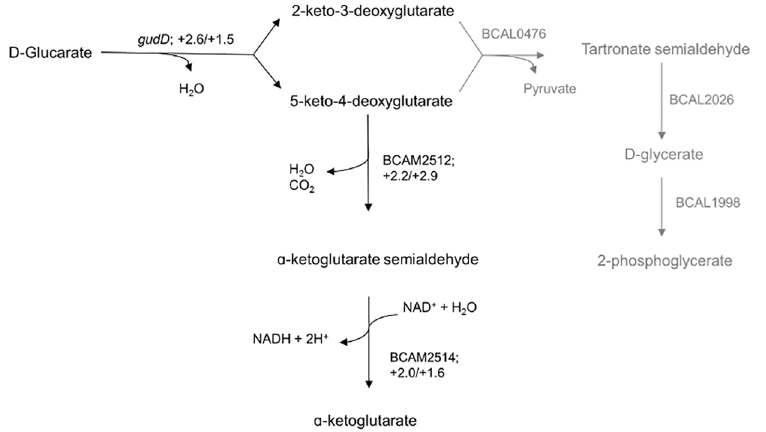
Fig 7. BH affects regulation of genes involved in glucarate metabolism of B . cenocepacia J2315. The reactions depicted in black are significantly (p < 0.05) upregulated (fold changes of “BH vs. Ctrl” / “TOB+BH vs TOB”). The involved enzymes are gudD (glucarate dehydratase), BCAM2512 (5-keto-4-deoxyglutarate dehydratase) and BCAM2514 ( ɑ -ketoglutarate semialdehyde dehydrogenase). For the reactions depicted in grey no significant differential expression in either “BH vs. Ctrl” or “TOB+BH vs TOB” was observed.